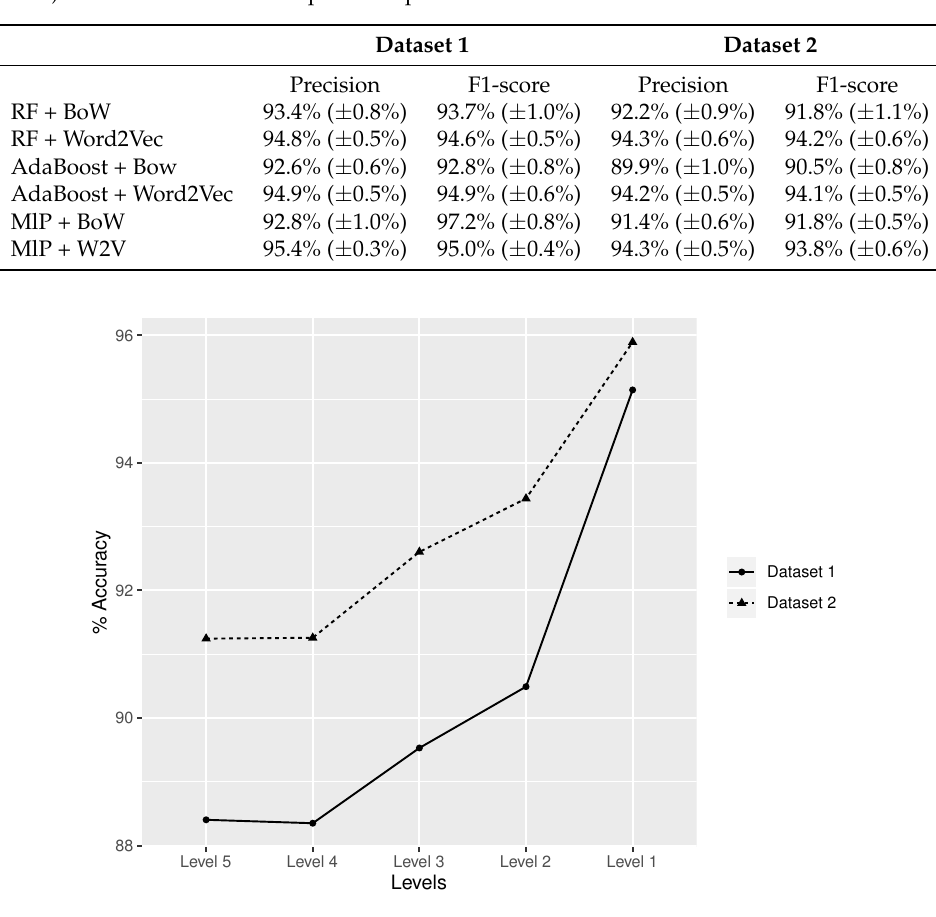
Figure 8. Accuracy computed at different levels of the account codes (target variable) for received invoices datasets. Model performances improve at lower levels since the target variable is more generic and the number of distinct categories is